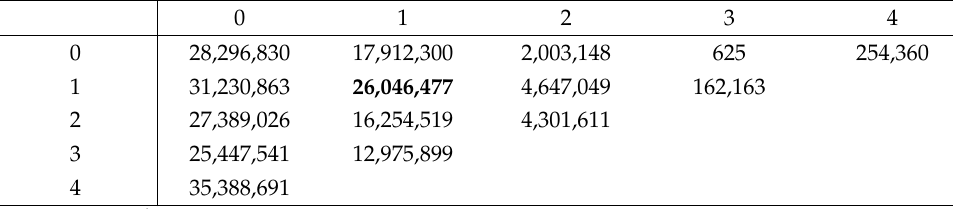
Table 11. Non-cumulative payments triangle after three steps of the heat equation in two